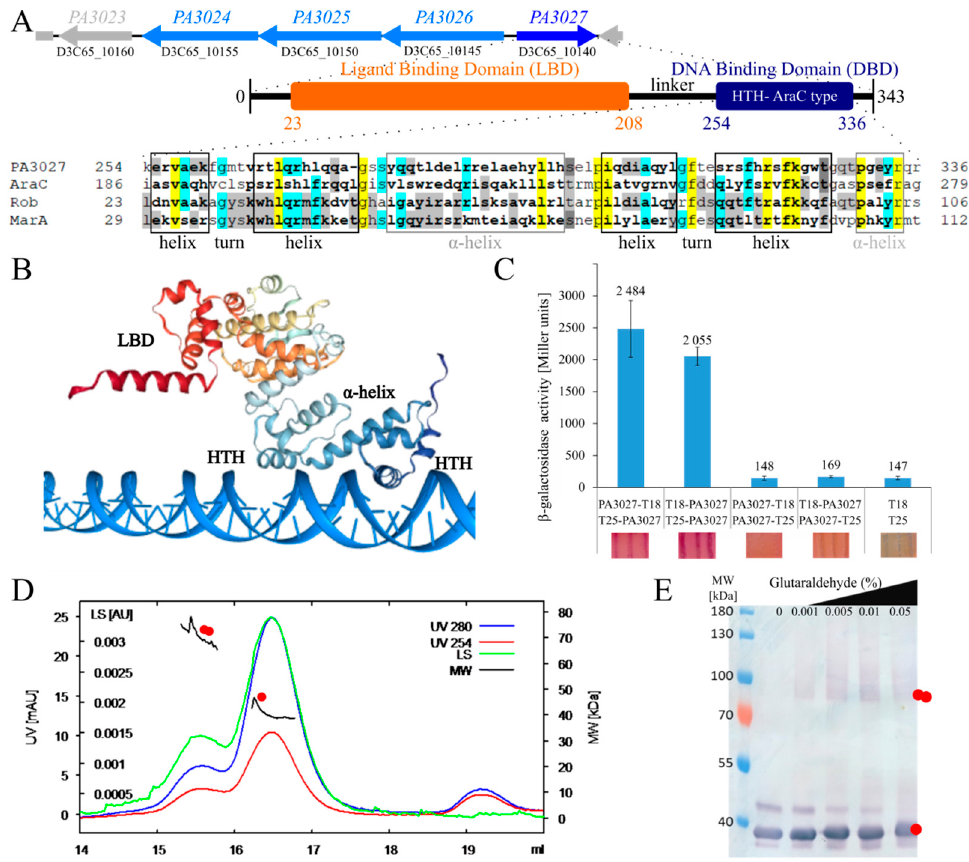
Figure 1. Properties of PA3027 protein from P. aeruginosa . ( A ) Genomic context of the PA3027 gene in the P. aeruginosa genome and domain structure of the PA3027 protein. The gene names from PAO1 and PAO1161 strains are presented. Alignment represents comparison of PA3027 HTH domain with corresponding regions of E . coli AraC (GenBank: CAA23508.1 ) , Rob (GenBank: CAD6017604.1), and MarA (GenBank: AAK21293.1). Sequences were aligned using Clustal Omega [36]. Identical residues